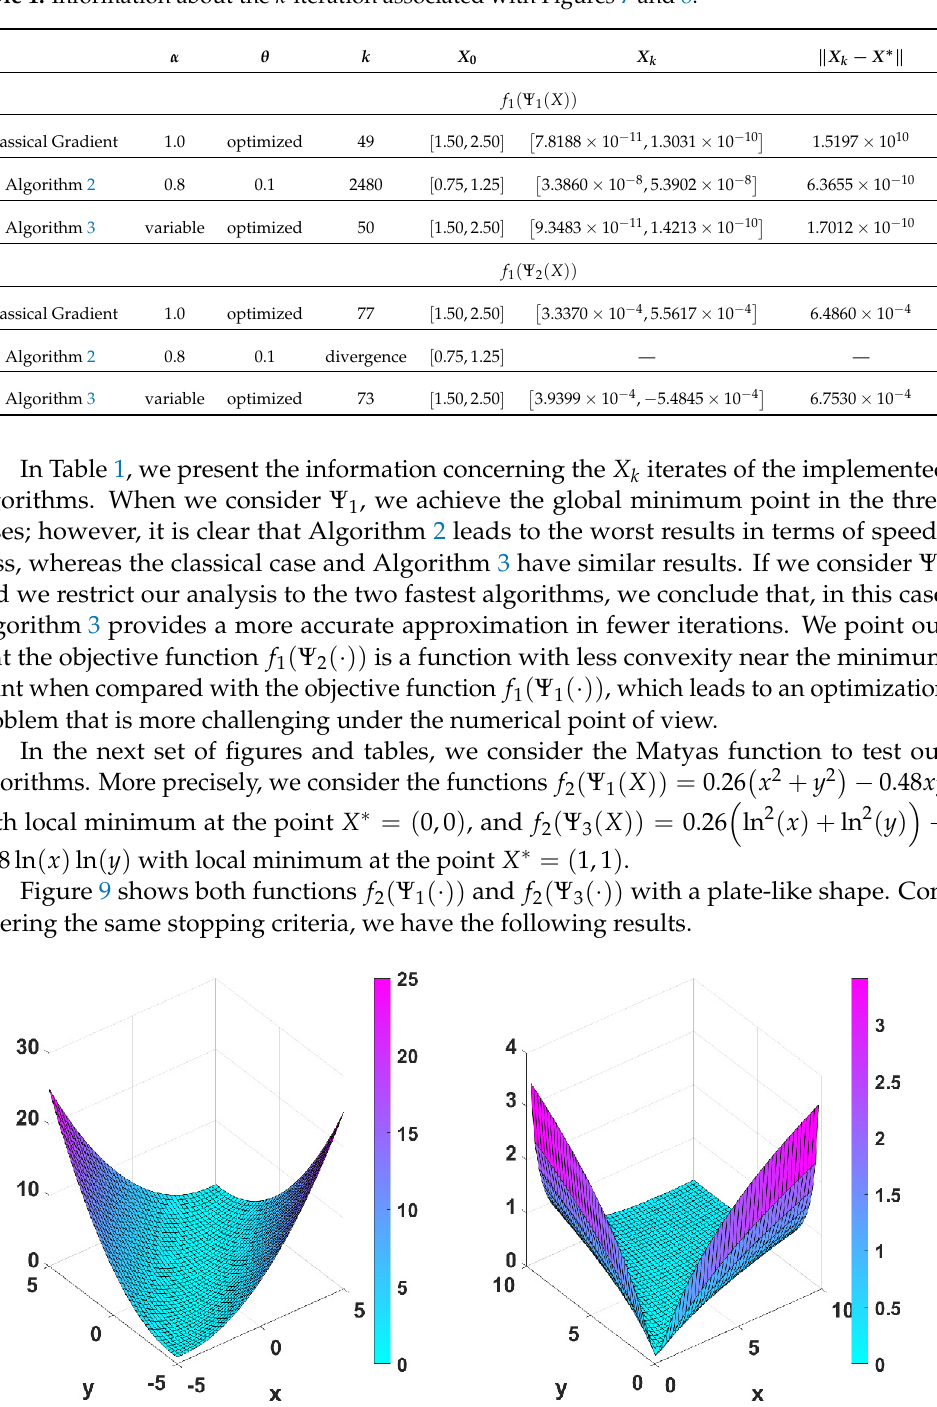
Table 1. Information about the k -iteration associated with Figures 7 and 8.